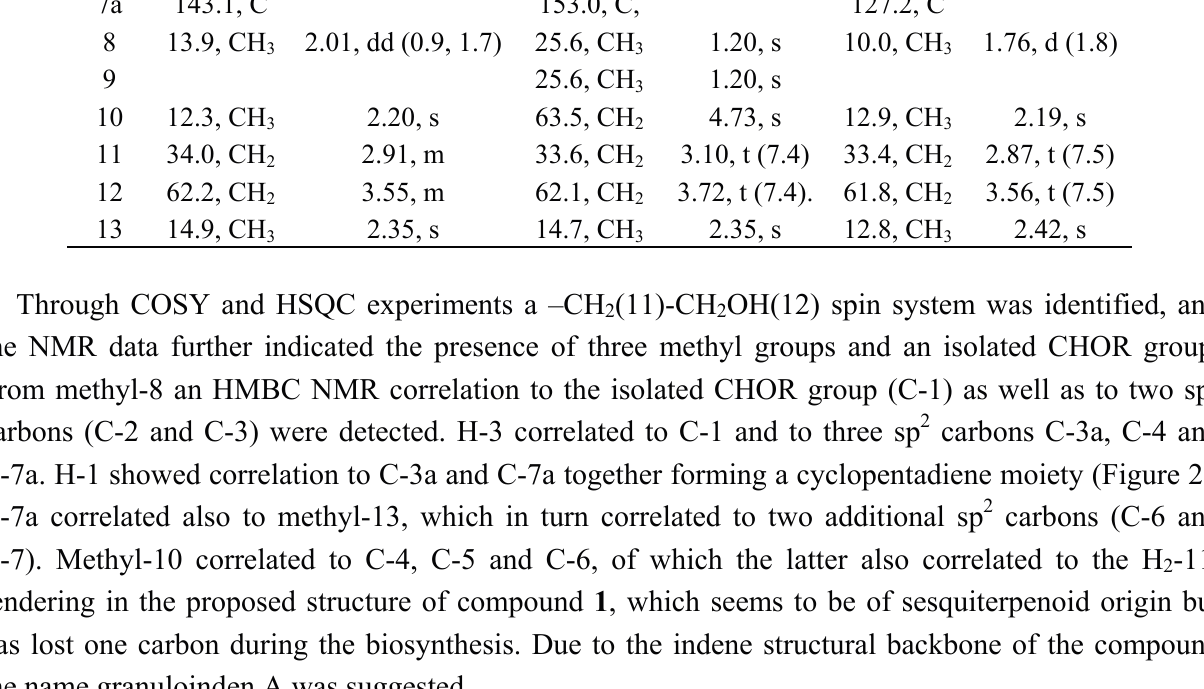
Table 1. 1 H- (600 MHz) and 13 C-NMR (100 MHz) data for compounds 1 – 3 (MeOH -d